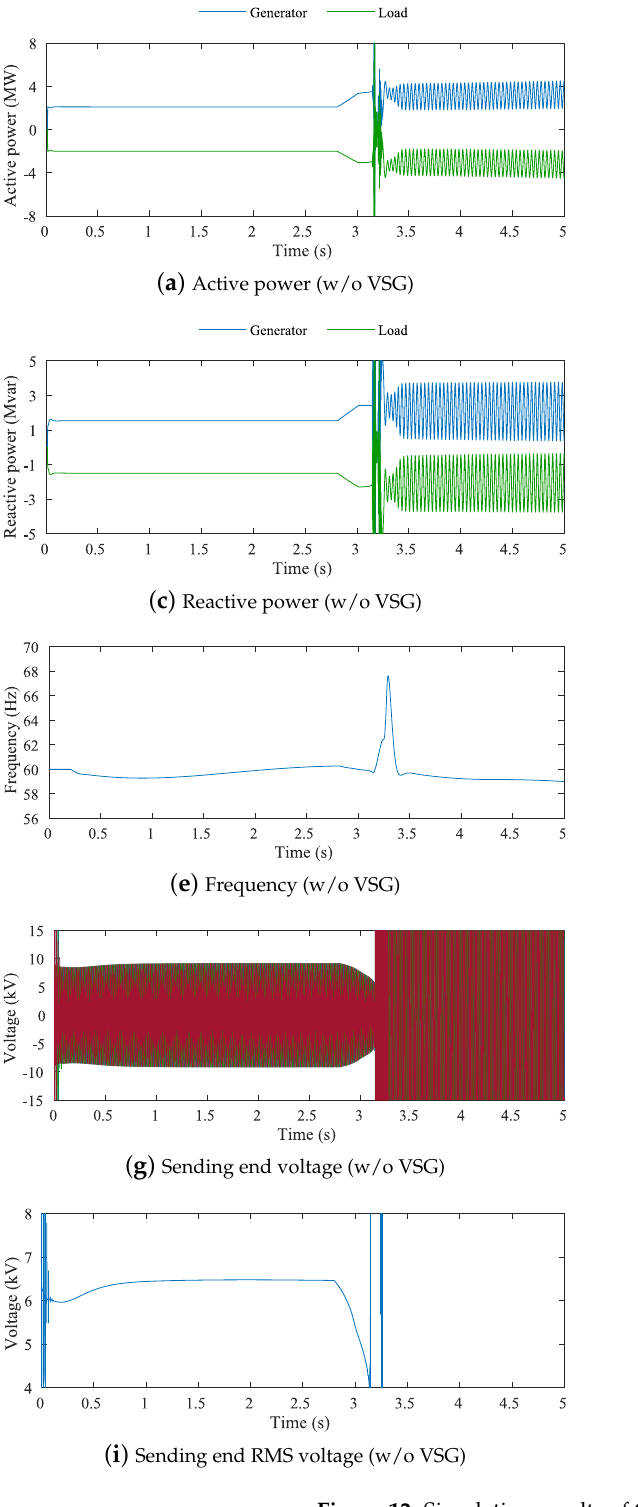
Figure 12. Simulation results of Case 1.2 with/without